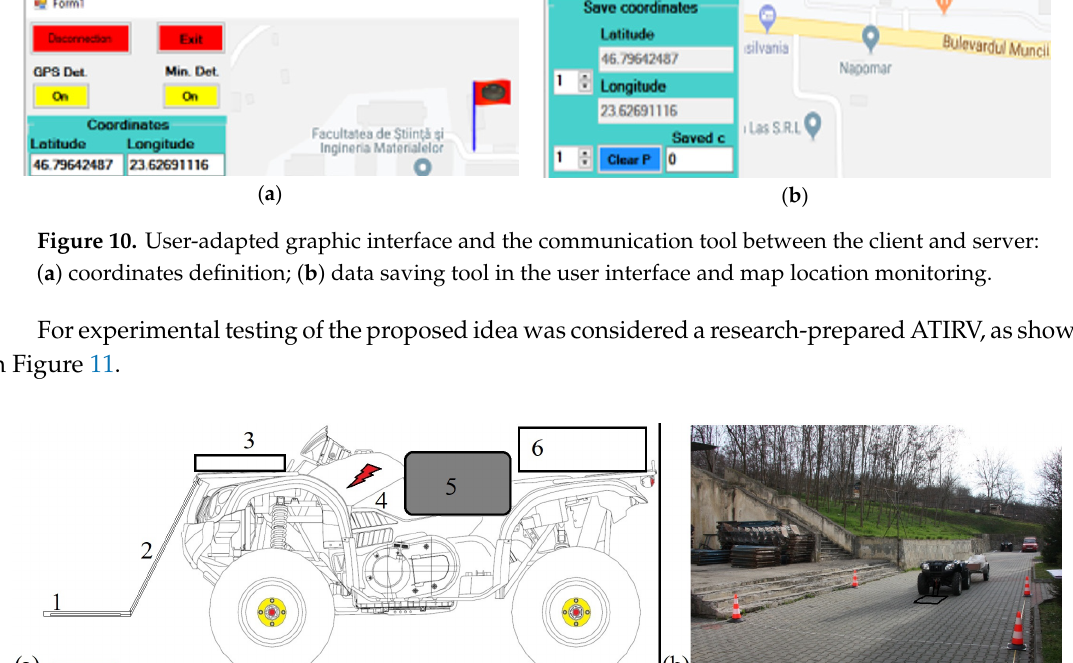
Figure 9. Feetech FD-v1.8 software application: ( a ) defining the ID of servo motor; ( b ) menu for kinematic and dynamic parameters definition.